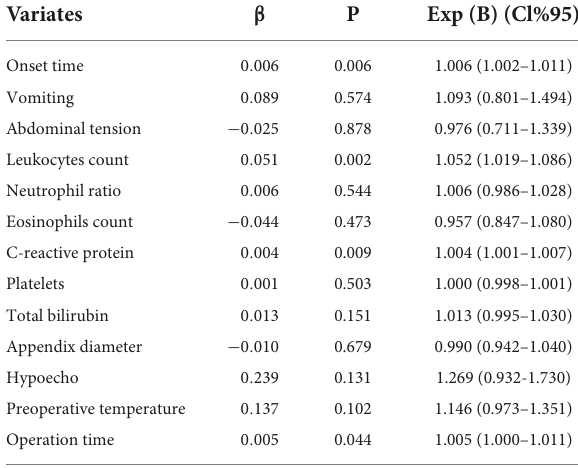
TABLE 2 Univariate logistic regression for variables filtration.